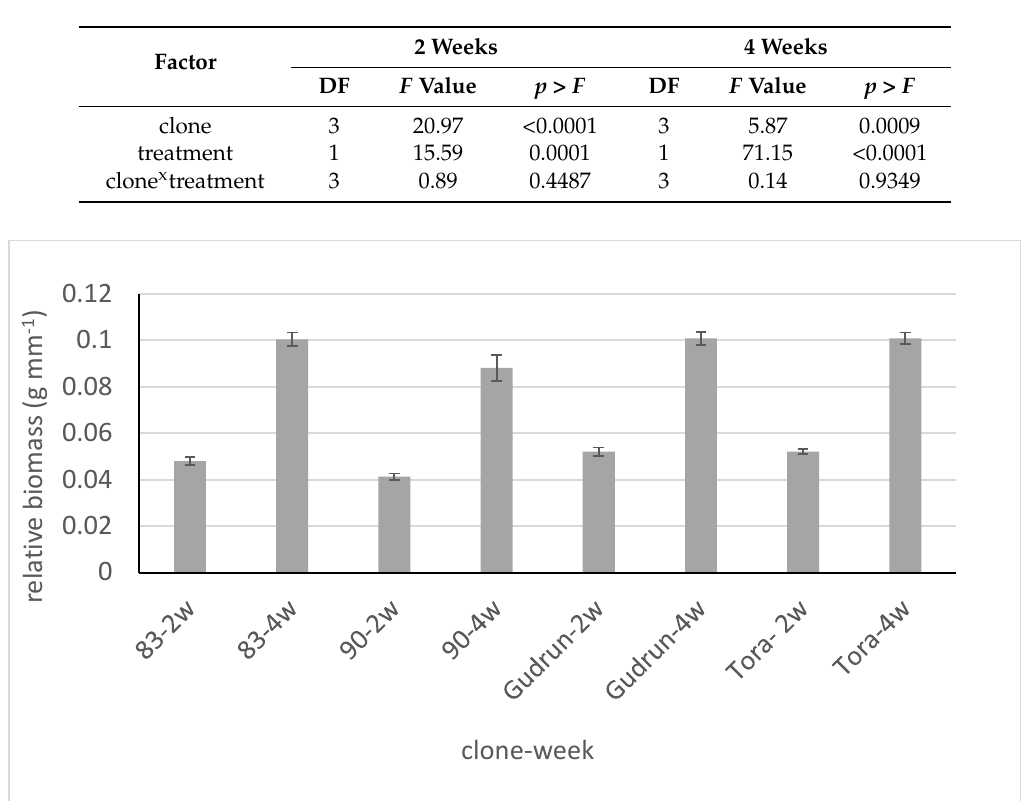
Table 4. The impact of clone and treatment on relative biomass (g mm −1 ) in 2010.